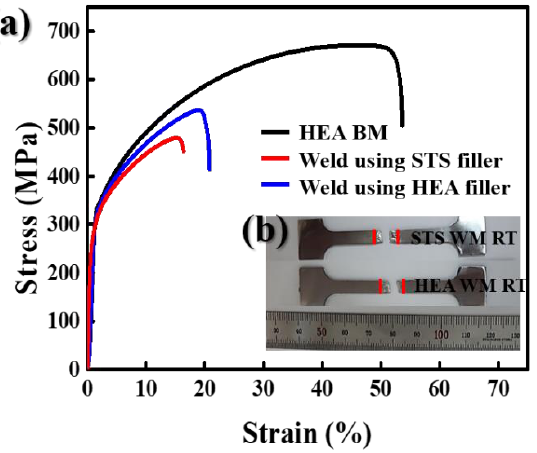
Figure 7. Tensile properties of rolled HEA BM and welds using HEA and STS 308L fillers tested at 298 K: ( a ) tensile stress-strain curves and ( b ) fracture positions in the welds.